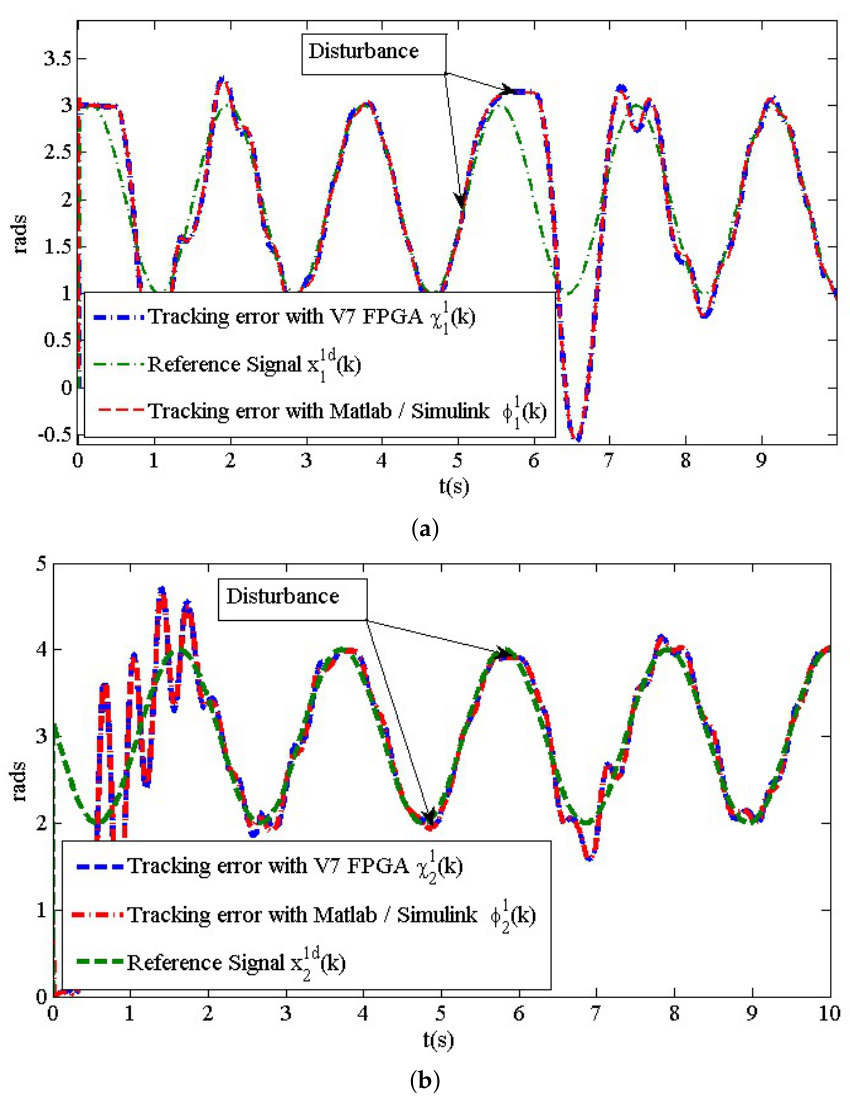
Figure 6. ( a ) Angular position tracking results for x 2 1 ( k ) , and ( b ) for x 1 ( k ) .